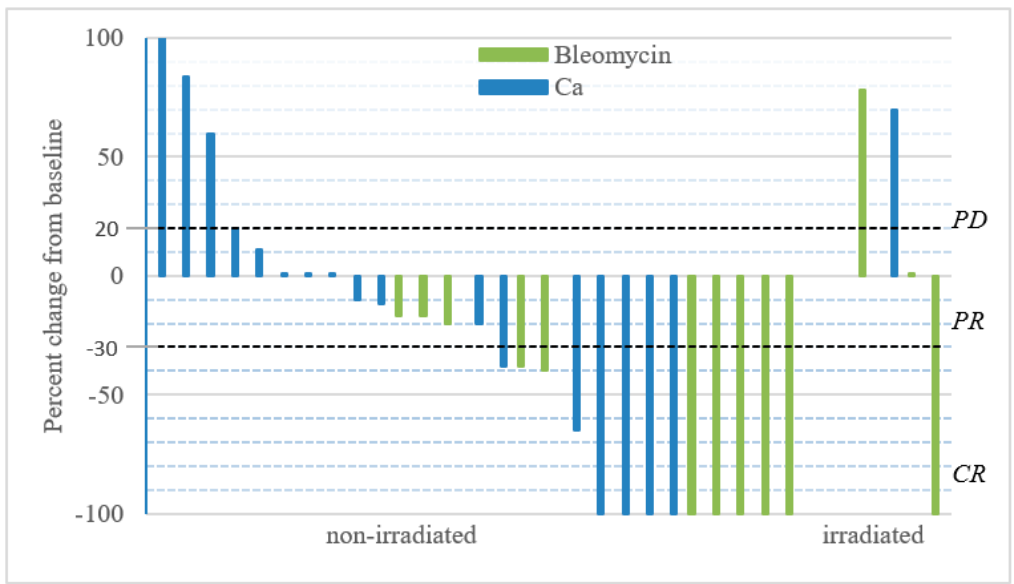
Figure 3. Change in tumour size over time. Metastases were treated at day = 0 with either i.t. calcium and or i.t. bleomycin in a randomized double-blinded study design. Patients received only one treatment and response was evaluated 6 months after treatment, after the randomization code was revealed. Change in size over time; the graph illustrates the percent change in tumour size recorded 6 months after treatment. The two non-measurable metastases treated with calcium-chloride and bleomycin were irradiated, and are not included in the graph, but were included in the response analysis as PD.